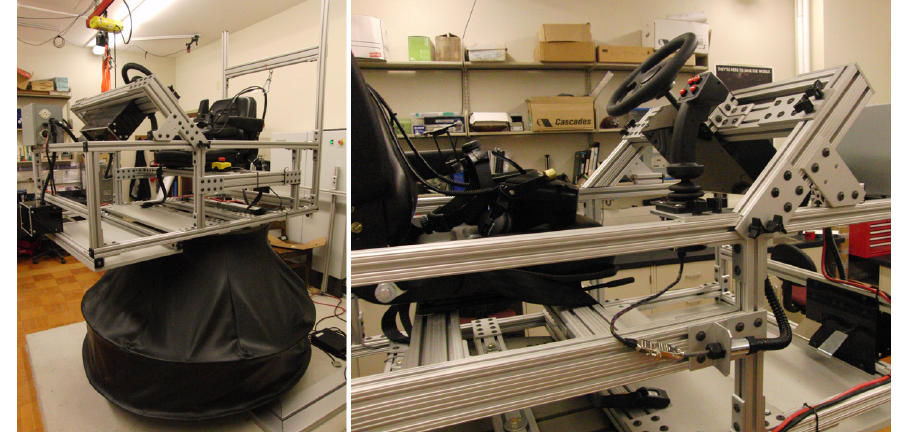
Figure 4. The left image shows the vehicle simulator mounted to the six degree of freedom robot; the robotic mechanism is shrouded for human subject safety. The right image shows the various controls that are within the vehicle simulator. The accelerator and brake pedals can be seen in the bottom right of the image. The haptic steering wheel and joystick are located at the top of the image.